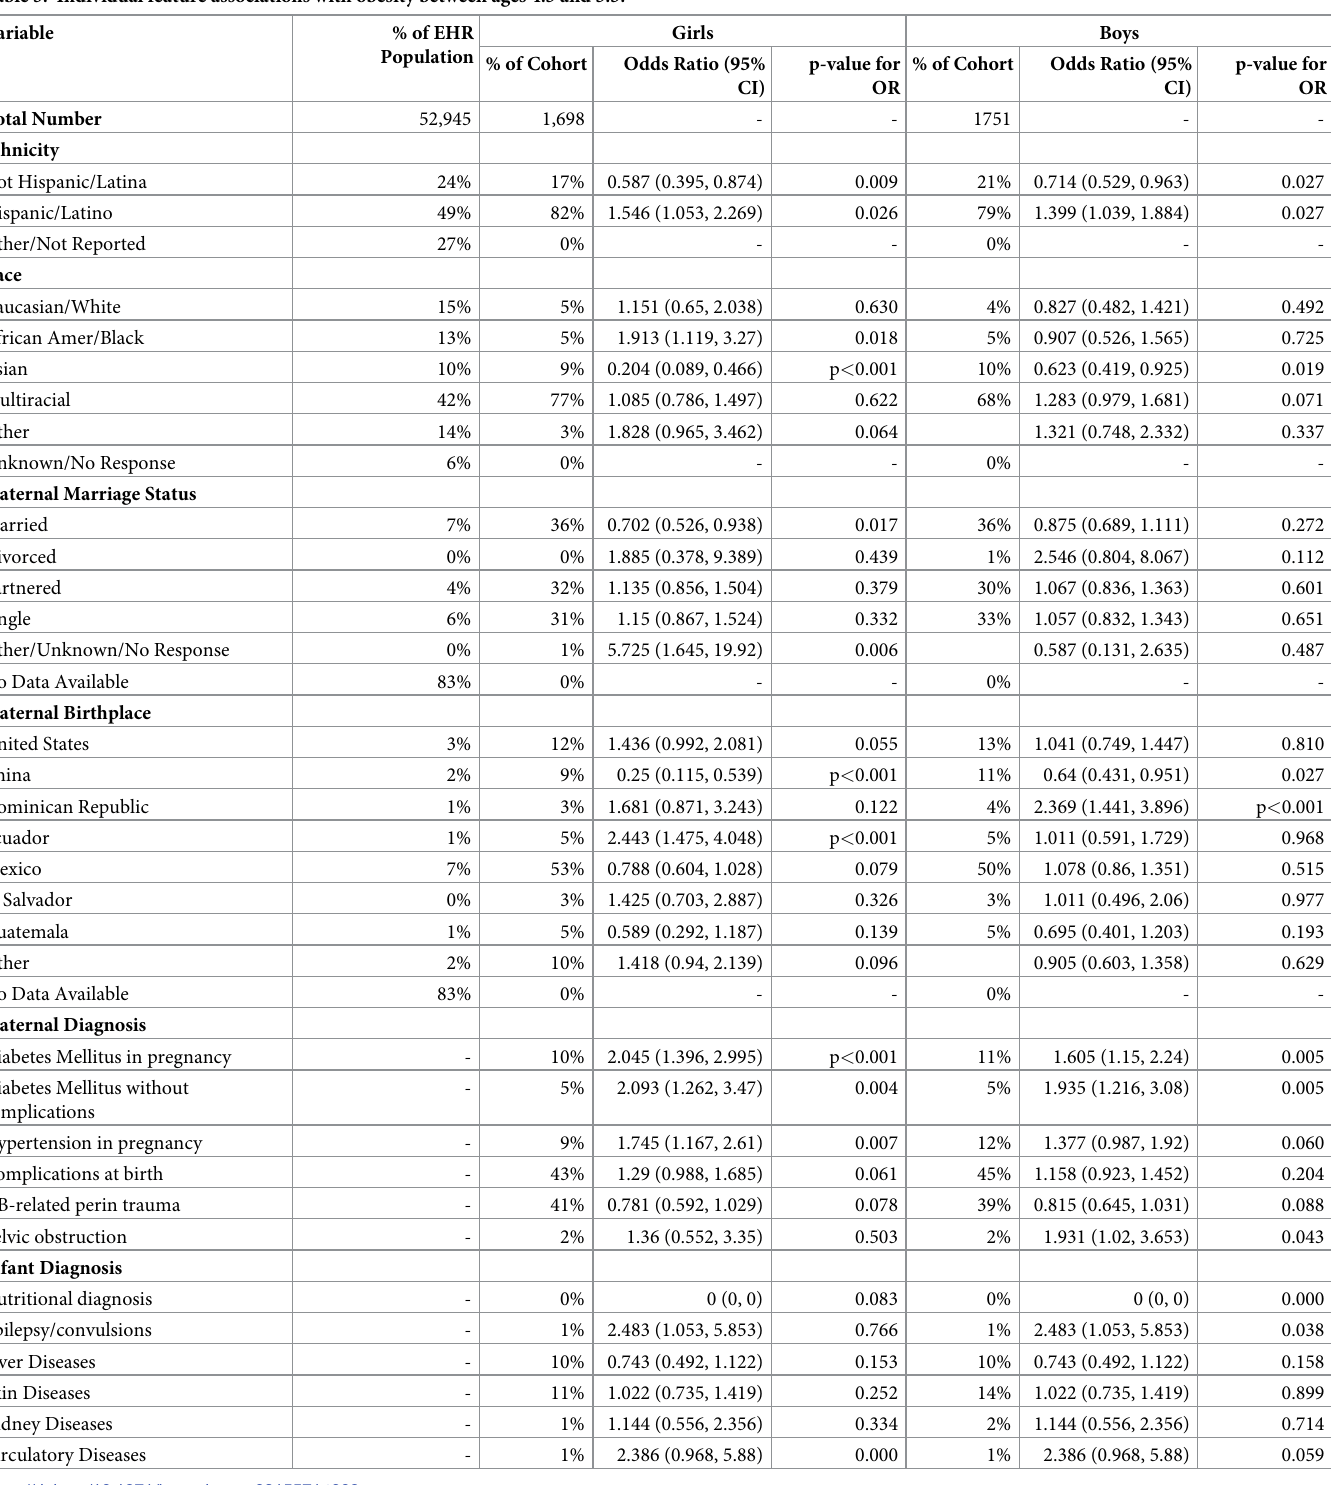
Table 3. Individual feature associations with obesity between ages 4.5 and